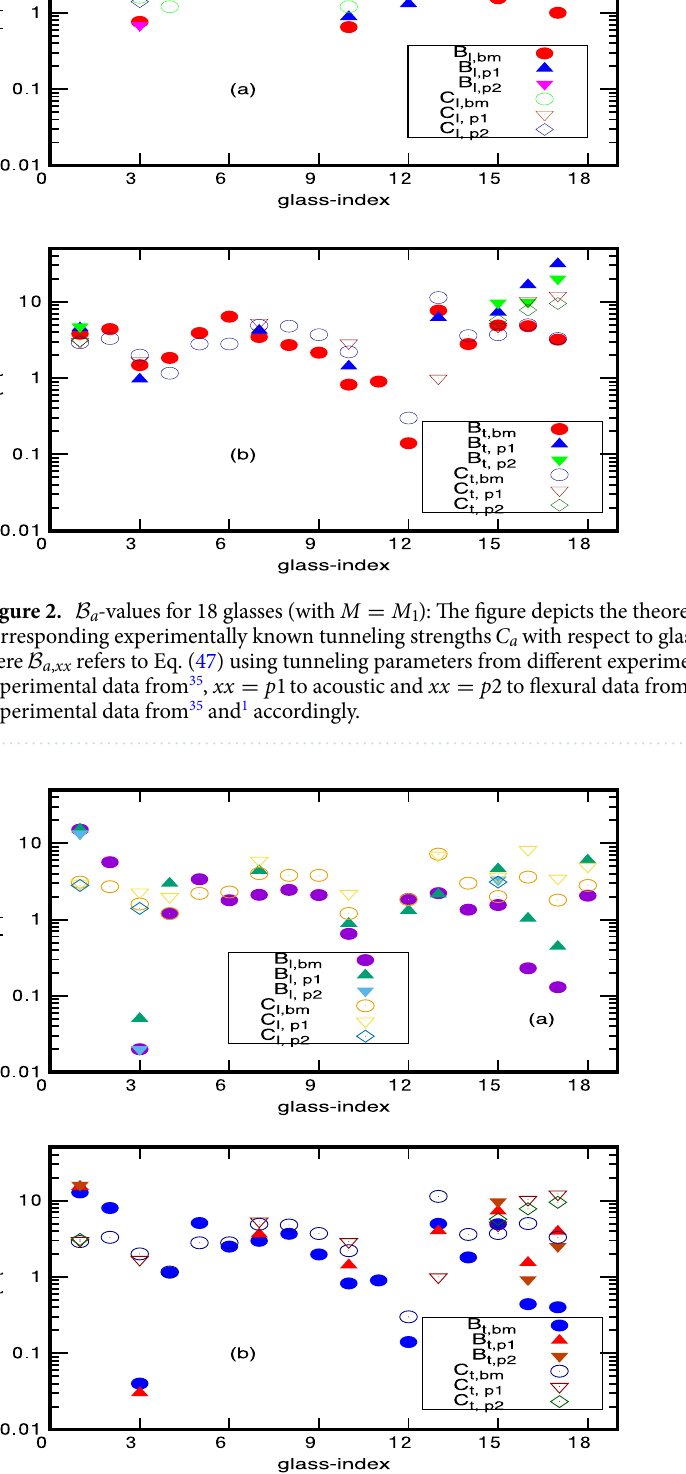
Figure 3. B a -values for 18 glasses (for M = M 2 ): All details are same as in Fig. 2 except that now the results for = M B 2 . Note although the correspondence with experiments here is not as a , xx from Eq. (47) correspond to M good as for M 1 , the deviation however is still within a factor of 10. As reported in Ref. 1 , the deviation of different experimental results lies also within that